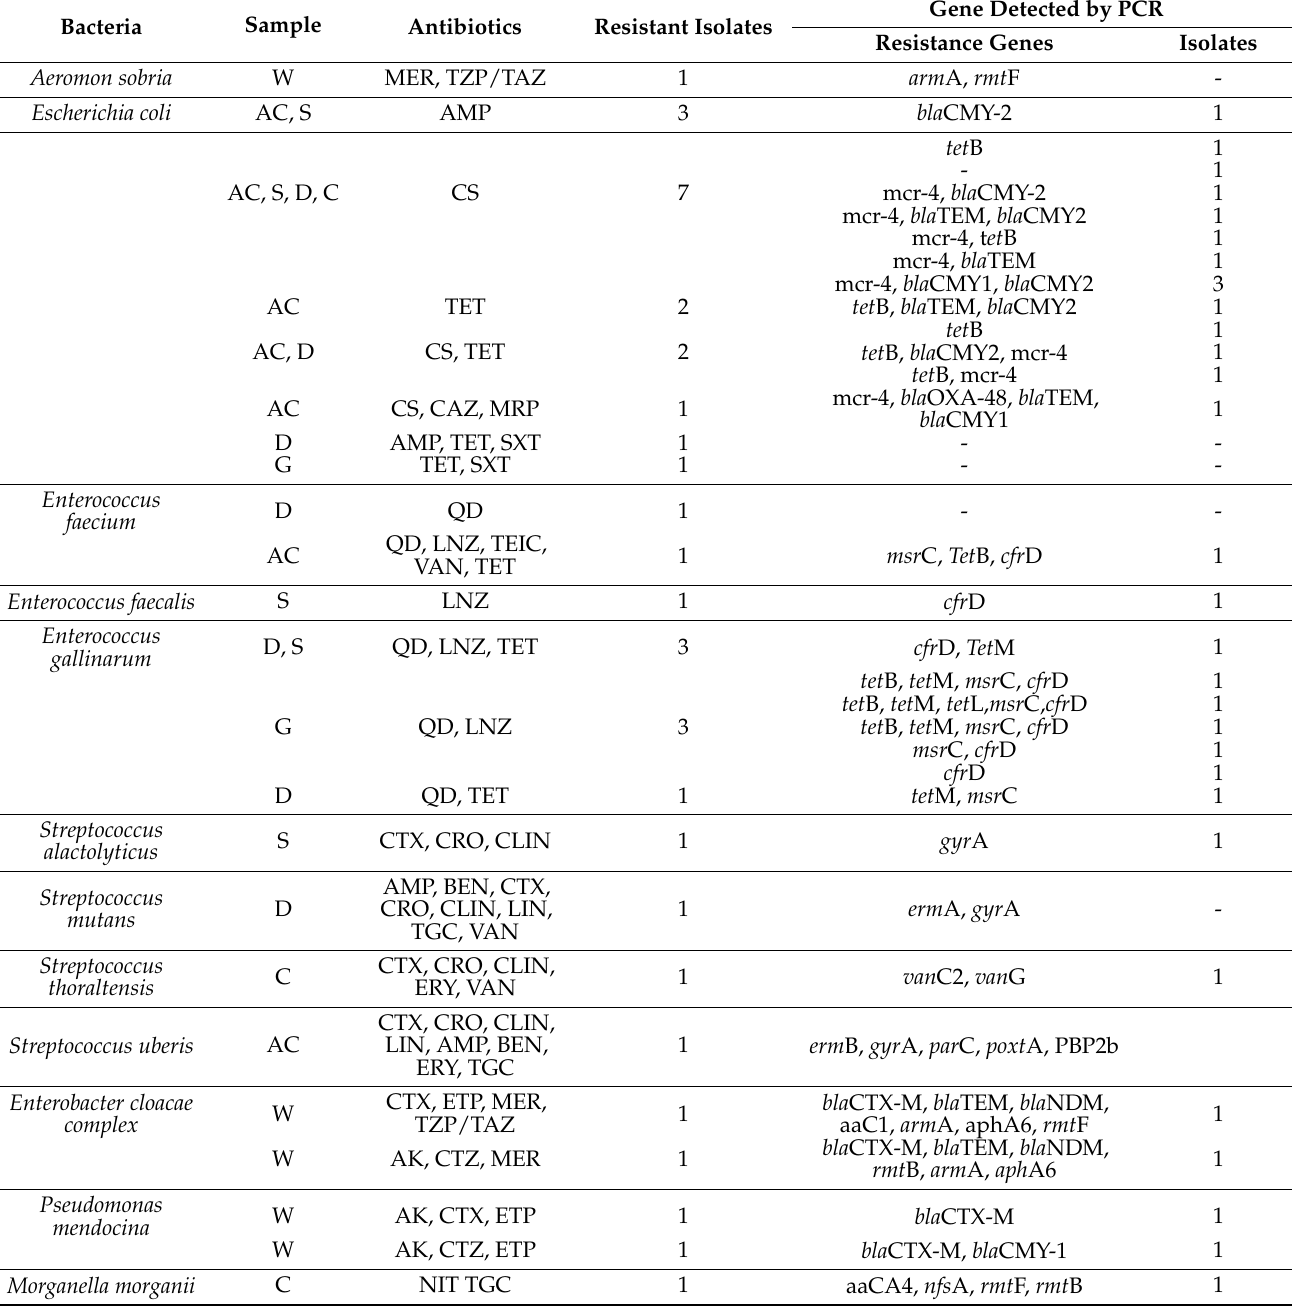
Table 3. Phenotypical and genotypical resistance profiles of bacteria isolated from fecal and water samples collected in investigated areas of Maiella National